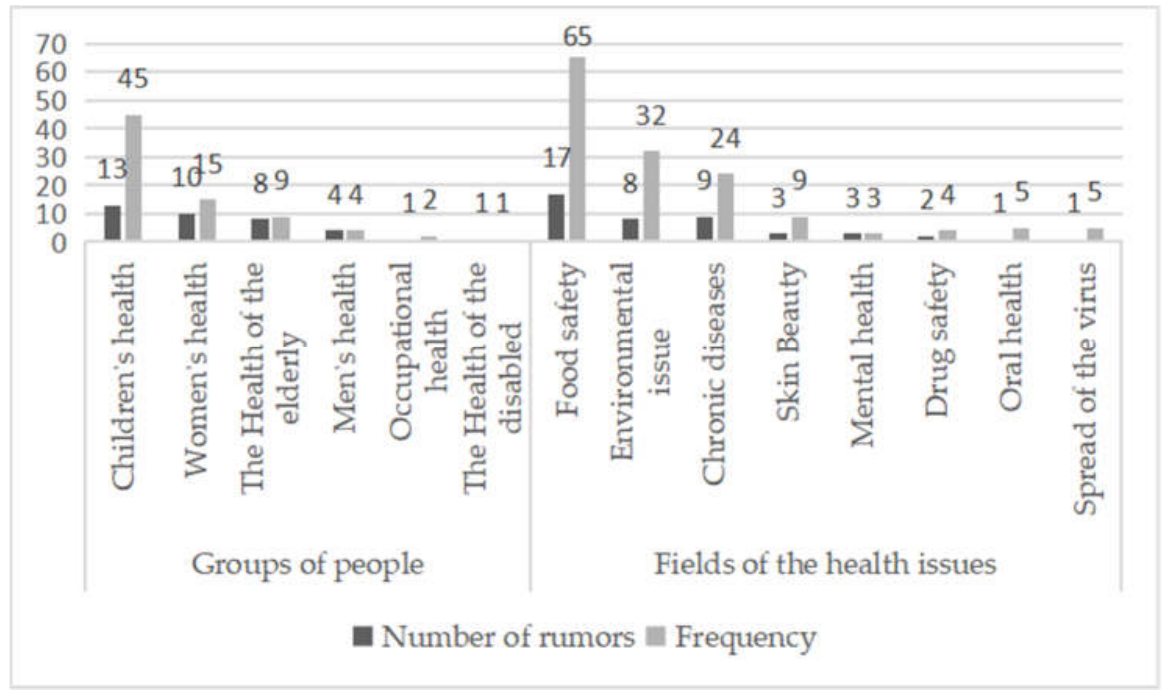
Figure 1. Number of rumors based on groups of people and encoded frequency based on fields of Internet health rumor.